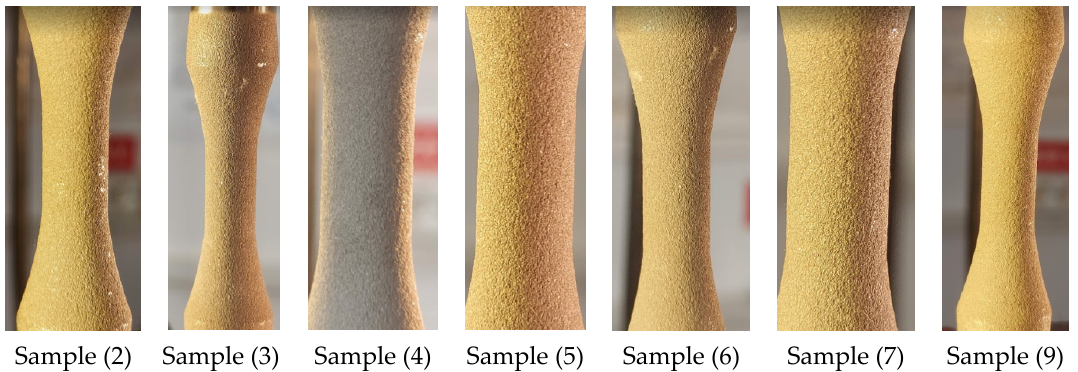
Figure 6. Outer surface during fatigue tests—different samples, near fracture point.